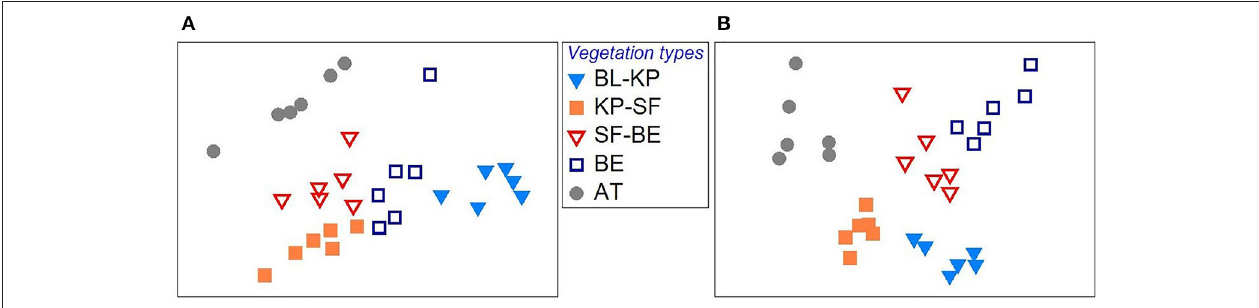
FIGURE 2 | The variation in bacterial (A) and fungal (B) community composition across the elevational gradient on Changbai Mt., as revealed by Non Metric Multidimensional Scaling (NMDS) plot based on Bray-Curtis distances. BL-KP, Broad leaf-Korean pine mixed forest; KP-SF, Korean pine-spruce fir forest; SF-BE, Spruce Fir- Betula ermanii forest; BE, Betula ermanii forest; AT, Alpine tundra.